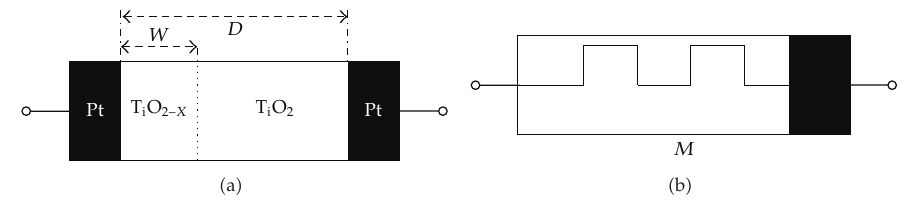
Figure 1: Structure (cid:2) a (cid:3) and symbol (cid:2) b (cid:3) of T i O 2